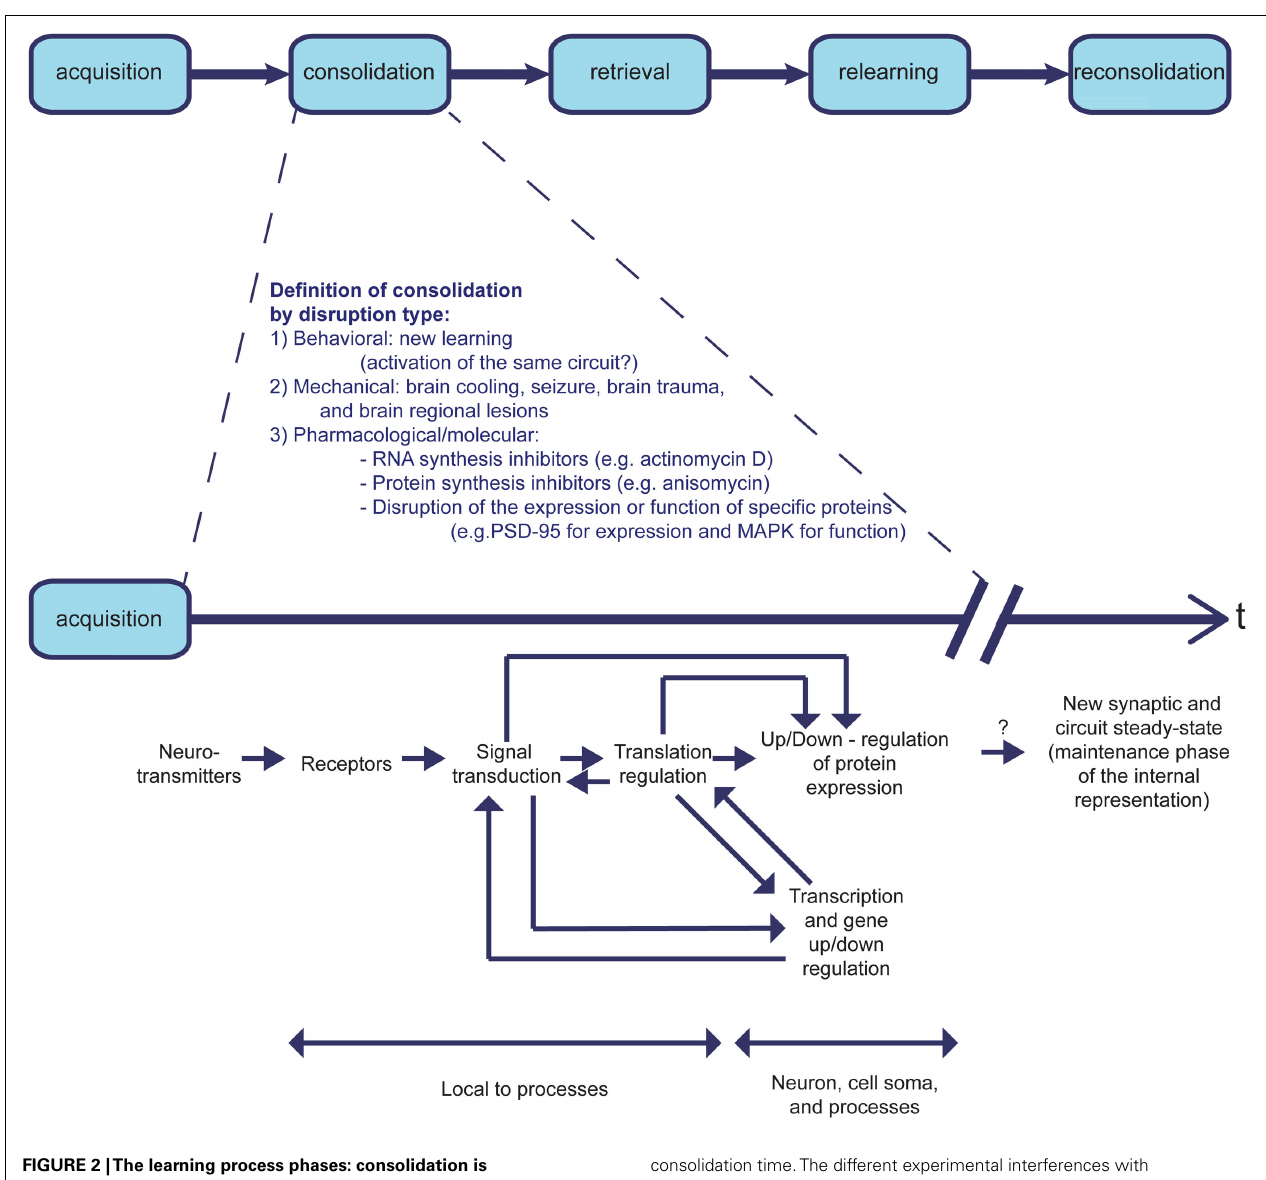
FIGURE 2 |The learning process phases: consolidation is determined by type of disruption. The learning process is ethologically divided into consecutive phases of acquisition, consolidation, retrieval, relearning, and reconsolidation.Whereas acquisition, retrieval, and relearning are defined in positive terms, the consolidation and reconsolidation phases are defined in negative terms. Therefore, the duration of the learning process is variable, and dependent on the type of experimental perturbation used to determine